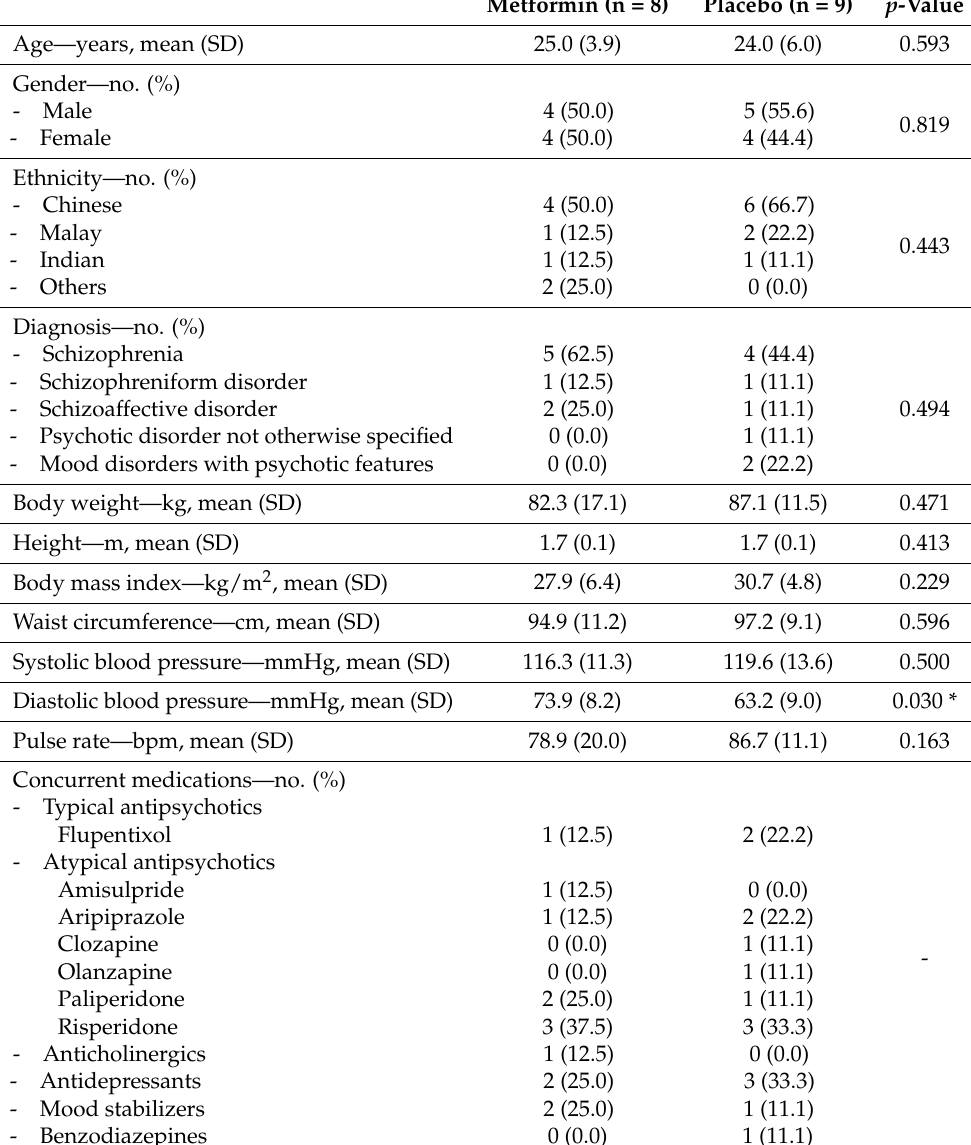
Table 2. Baseline demographic and clinical characteristics of the enrolled participants (n = 17).